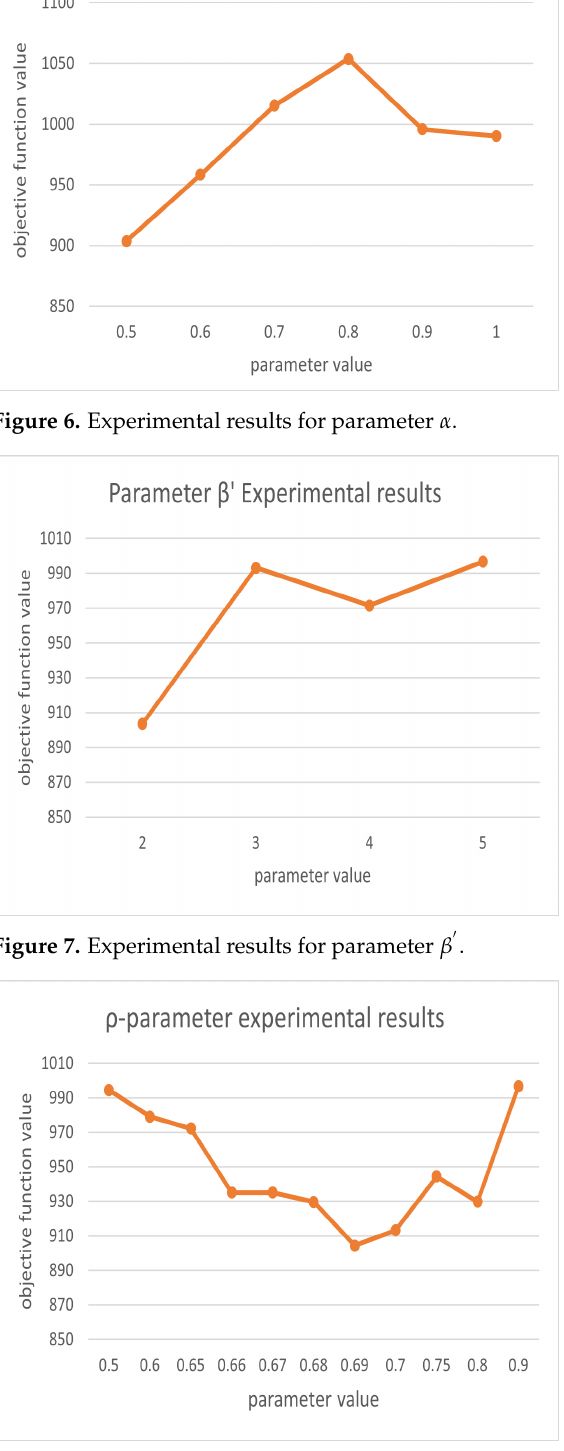
Figure 8. Experimental results for parameter ρ